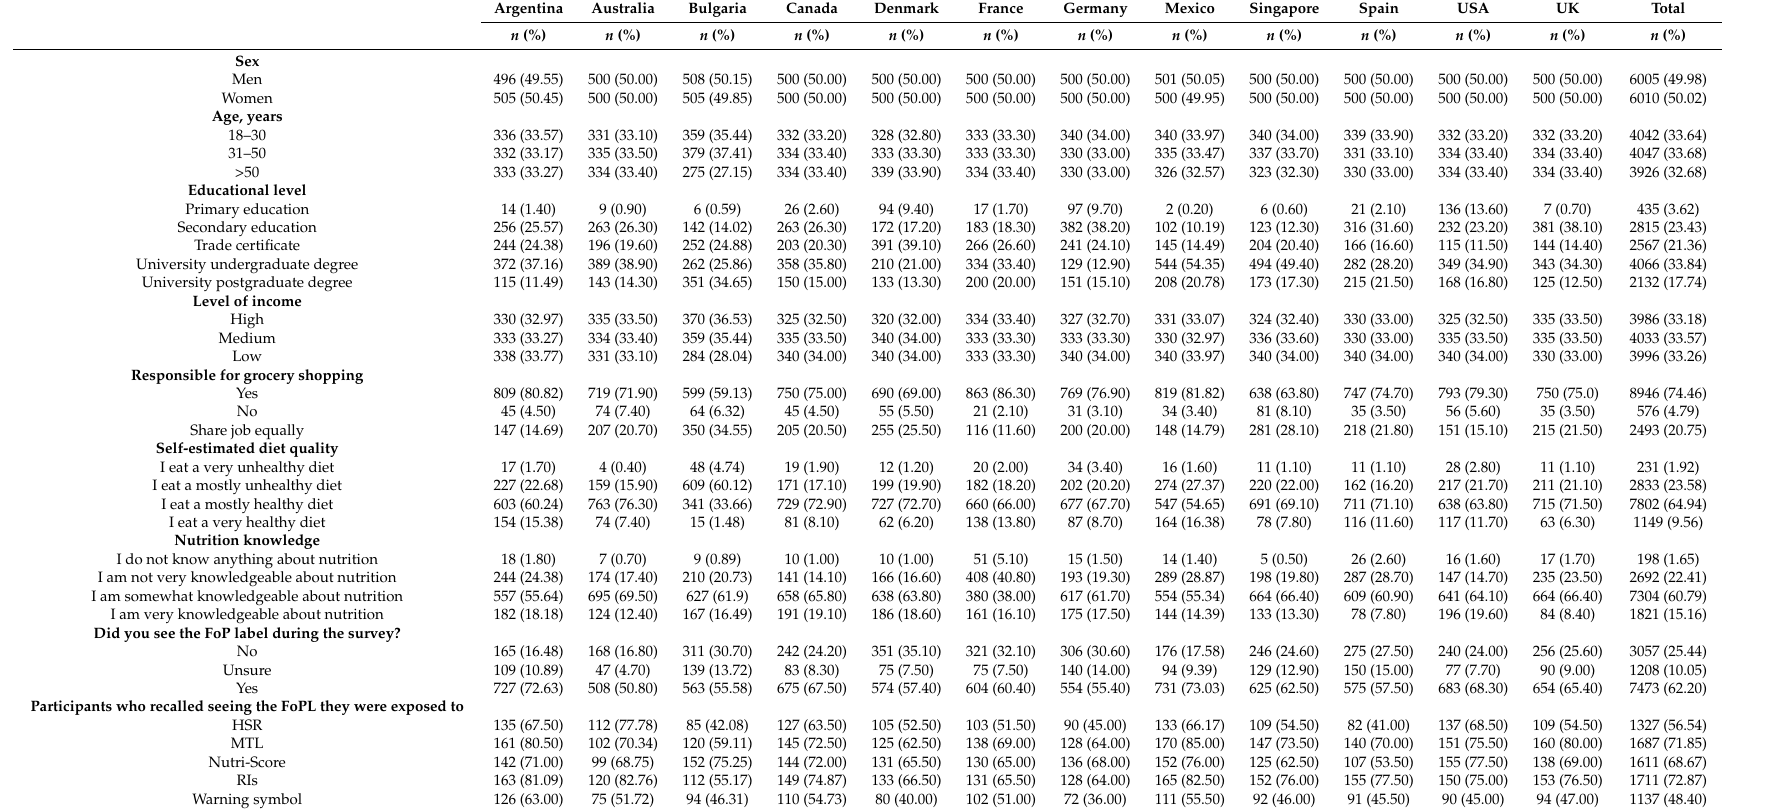
Table 1. Individual characteristics of the study sample ( n =